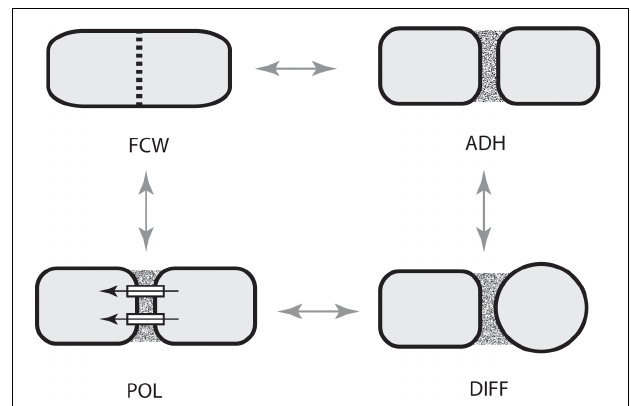
FIGURE 4 | Paired dynamic patterning modules (indicated by arrows) that participate in the evolution of multicellularity. The acquisition of each of these modules is required for the evolution of multicellularity. These modules operate in pairs for organisms with cell walls because cell-to-cell adhesion is related to the location of a new cell wall and because intercellular communication operates in tandem with cell polarity. ADH, the capacity for cell-to-cell adhesion. DIF, the establishment of intercellular communication and cellular differentiation, FCW, the future cell wall module (establishes the location and orientation of the new cell wall), POL, the capacity for polar (preferential) intercellular transport. (Adapted from Hernández-Hernández et al.,